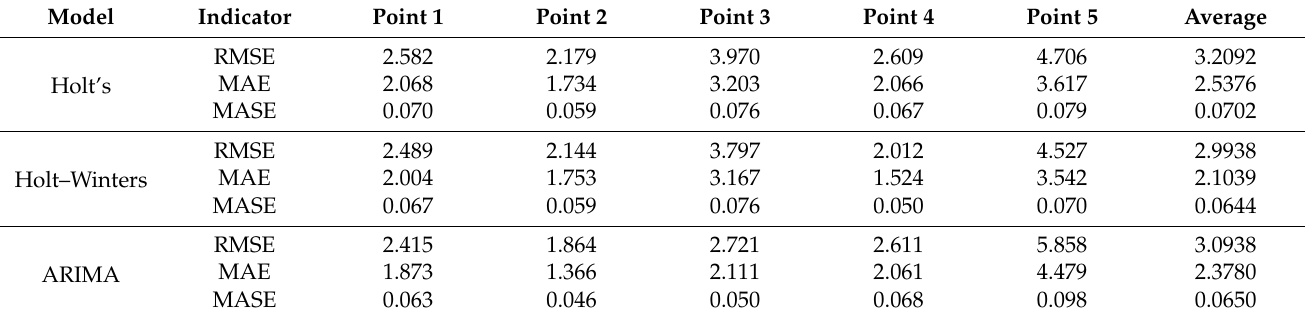
Table 3. Comparison of predictive model performance indicators.